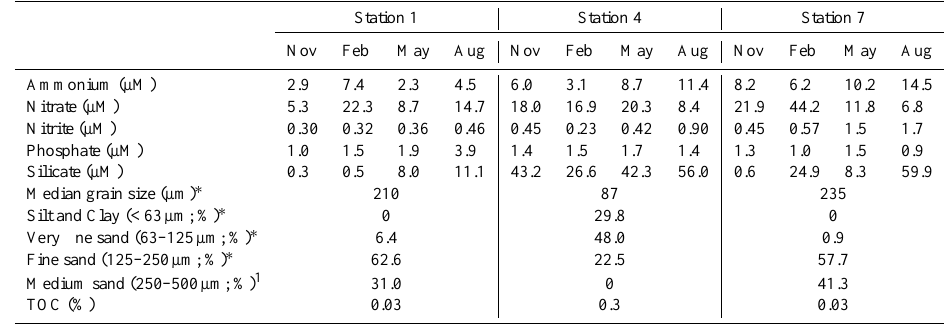
Table 2. Geochemical properties and pore water composition of surface sediment (0–1cm) at three stations in the North Sea during different